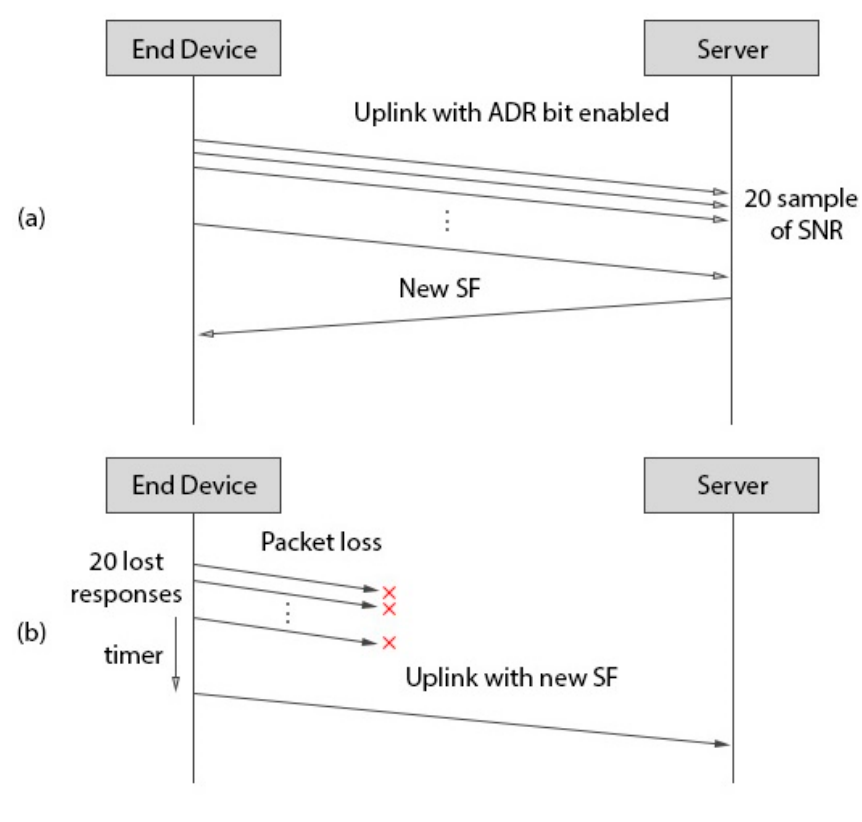
Figure 5. Selection of the new spreading factor (SF): ( a ) decreasing mechanism; ( b ) increasing